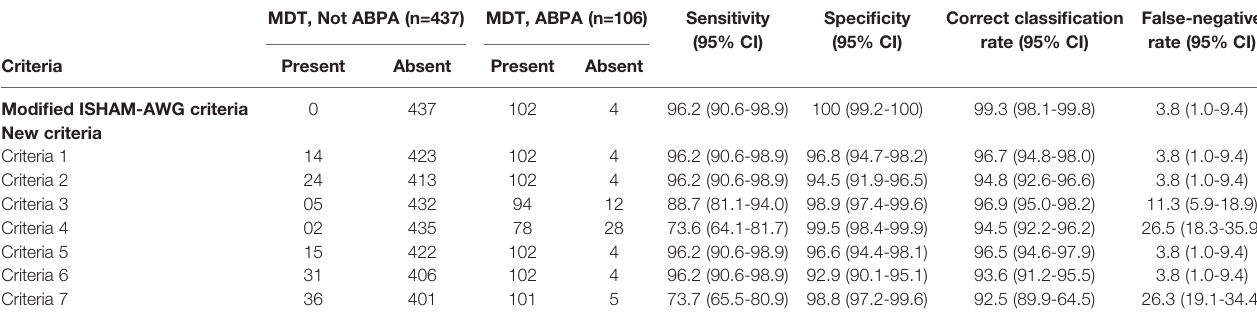
TABLE 4 | Performance of various diagnostic criteria for allergic bronchopulmonary aspergillosis (ABPA) using the multidisciplinary team (MDT) evaluation as the reference